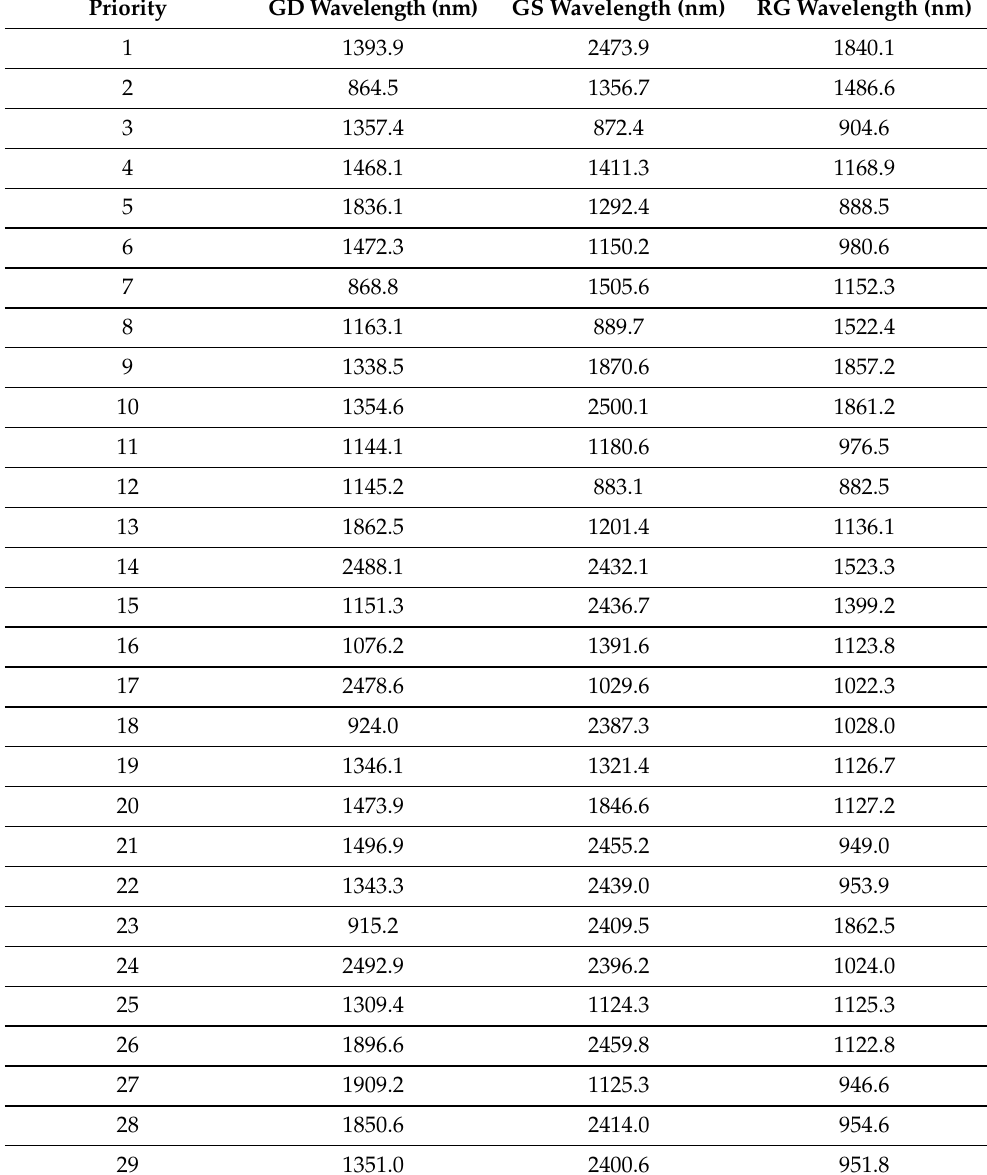
Table A1. Features/wavelengths for identifying bruised/sound apples in order of priority, for different apple